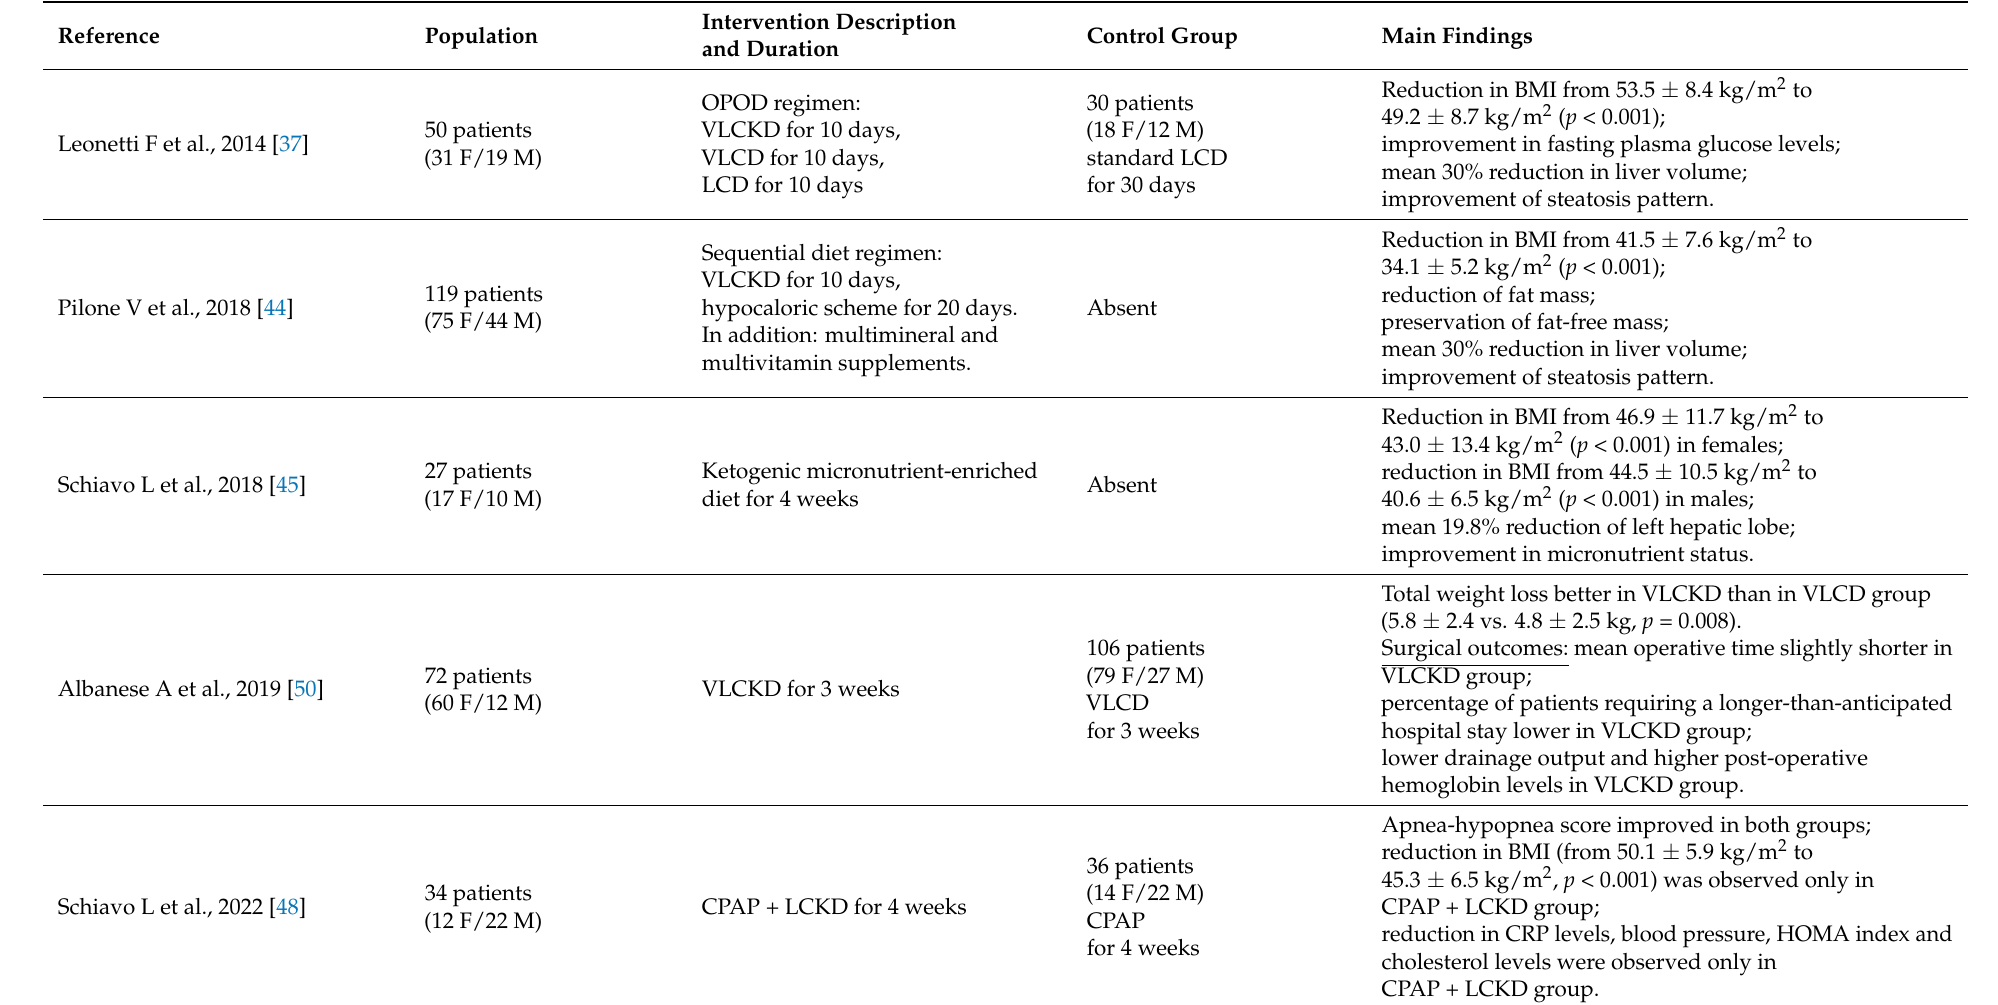
Table 1. Main findings of studies on KD before